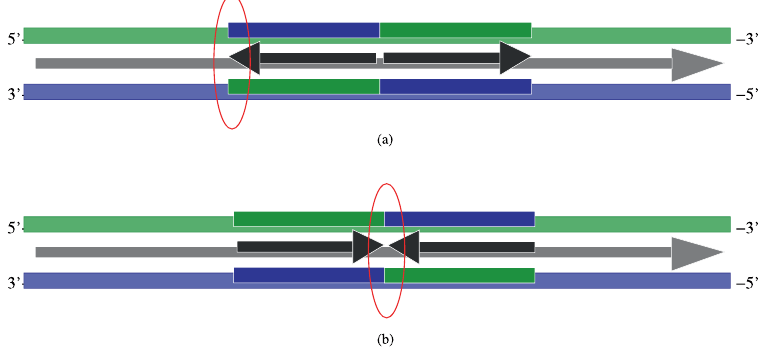
Figure 11. Schematic diagram illustrating the emergence of palindromic instability from sequence-dependent asymmetric cooperativity. The figure illustrates the effect of insertion of a palindromic sequence within a single replichore with a right asymmetric cooperativity mode. Due to the dyadic symmetry of a palindromic sequence, the asymmetric cooperativity modes of the two arms of the palindromic sequence point in opposite directions. The hydrogen bonds at an interface where the two asymmetric cooperativity arrows point at each other will have their kinetic barriers reduced, weakening the bonds and resulting in localized unzipping. There are two types of palindromic sequences: ( a ) When two the asymmetric cooperativity modes from the two arms of the palindrome point away from each other, one of the two ends of the palindrome become unstable due to the change of cooperativity mode. This end is highlighted with a red ellipse in the figure. ( b ) When the modes from the two arms are such that the arrows point at each other, the bonds at the center of the palindrome will weaken, leading to local unzipping and cruciform extrustion. These locations on the genome are vulnerable to break, due to the instability introduced by localized